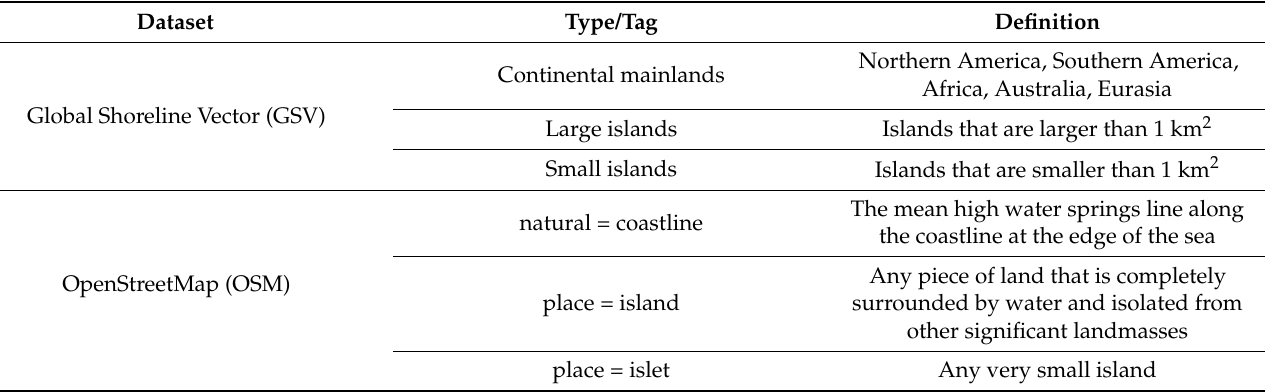
Table 2. The attributes of the two island datasets (GSV and